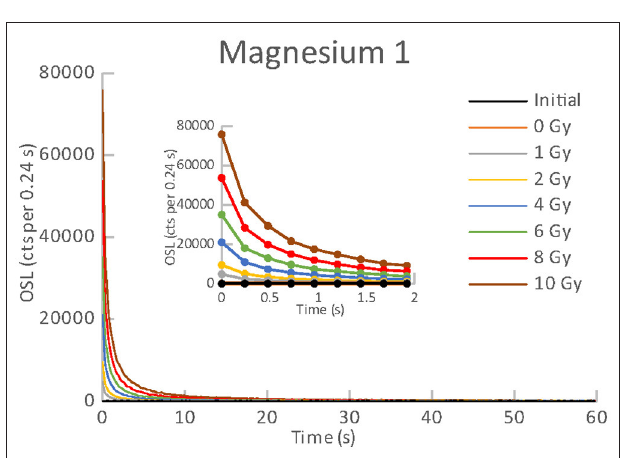
FIGURE 6 | OSL curves for the initial readout and subsequent post-irradiations readouts of an aliquot of Magnesium 1.